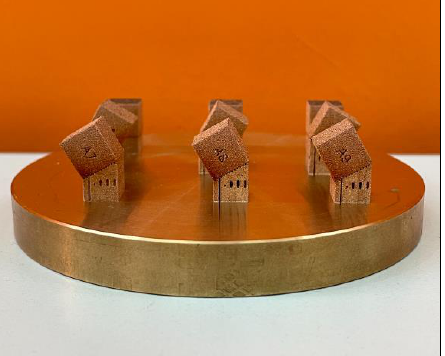
Figure 3. Print Job I: A # specimens’ production results on the building